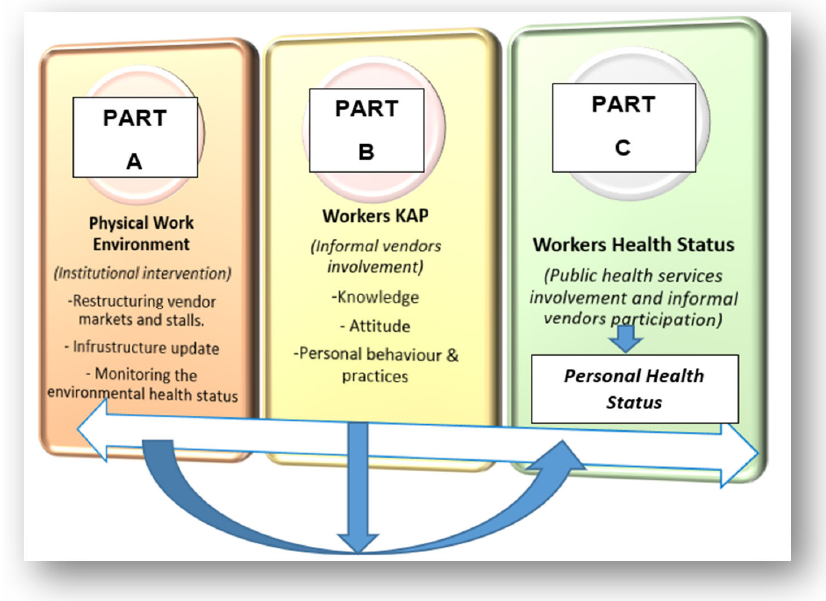
Figure 2. Informal vendors’ environmental and occupational health three-way framework.